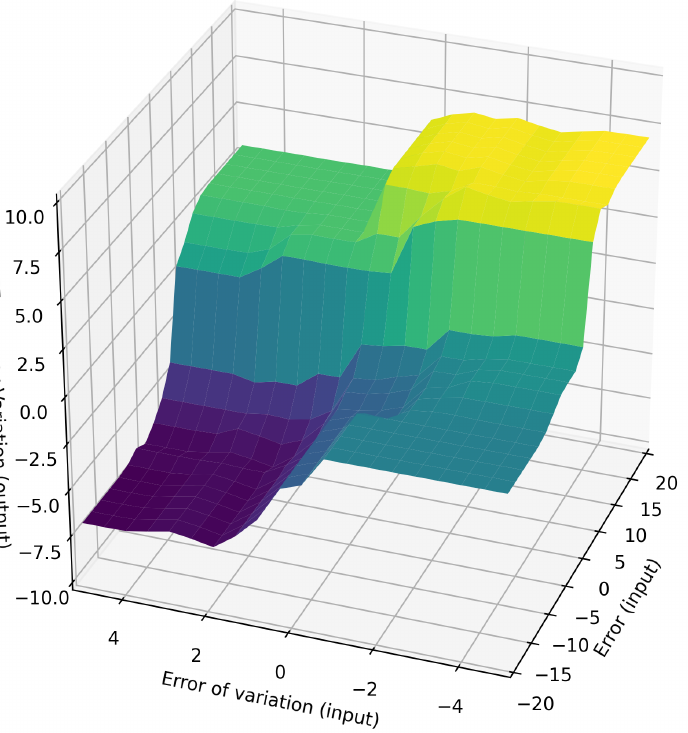
Figure 6. Relationship between: the inputs—Error variation and error; the